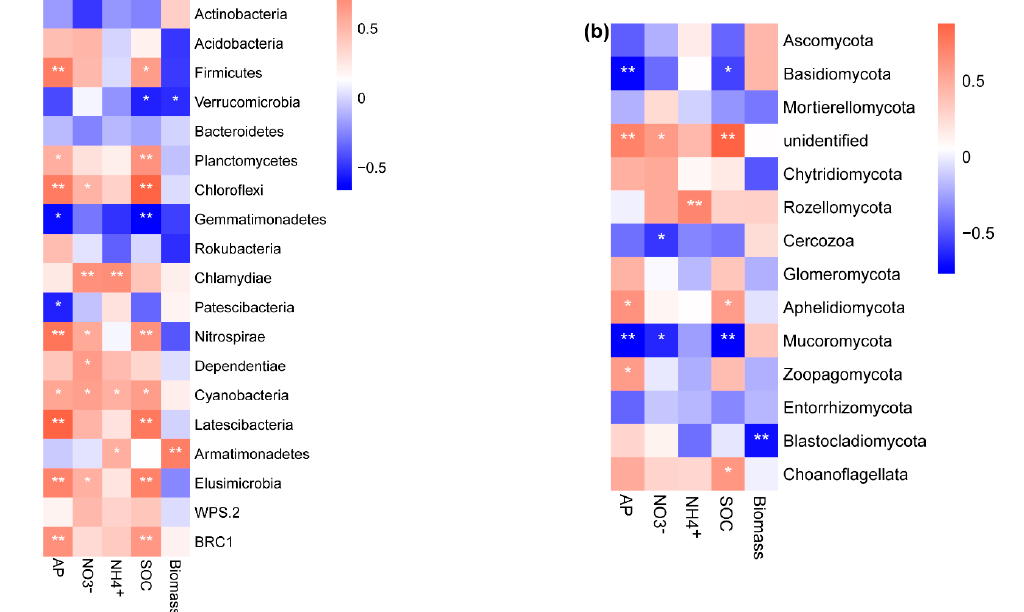
Figure 5. Spearman correlation analysis between ( a ) bacterial phyla, ( b ) fungal phyla, soil nutrients, and seedling biomass. AP, soil available phosphorus; NO − ammonium nitrogen; SOC, soil organic carbon; Biomass, total seedling biomass. Asterisks represent significant effects (*, p < 0.05; **, p < 0.01).